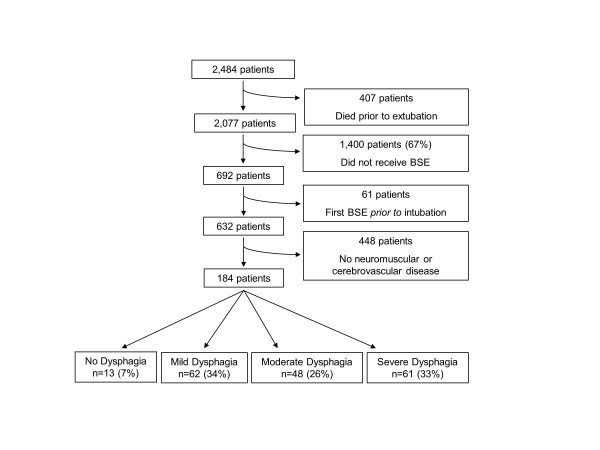
Flowchart detailing enrollment of subjects. BSE, bedside swallow evaluation.